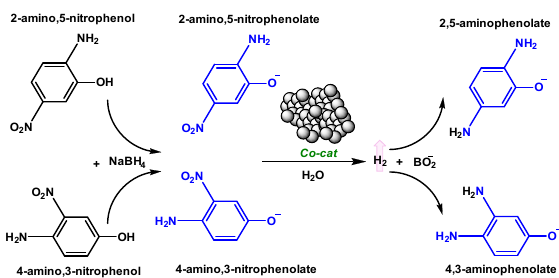
Figure 9. Reaction process of amino-nitrophenols with catalysts Co@100, Co@350 and Co@600 (“Co-cat”) in H 2 O with excess NaBH 4 .